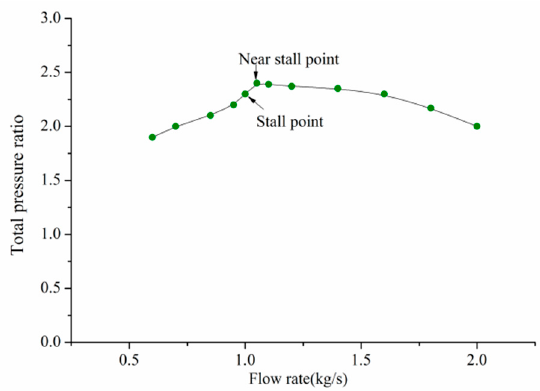
Figure 13. The compressor performance curve of the flow rate and pressure ratio.